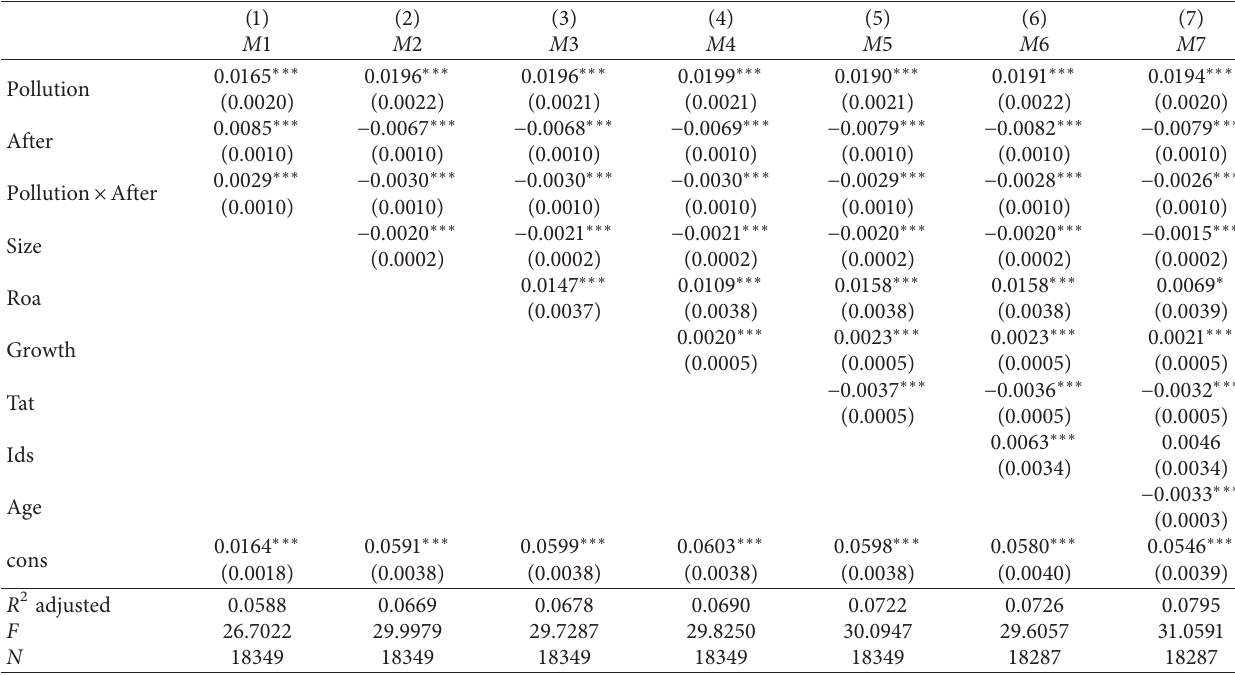
Table 4: The impact of green credit on investment